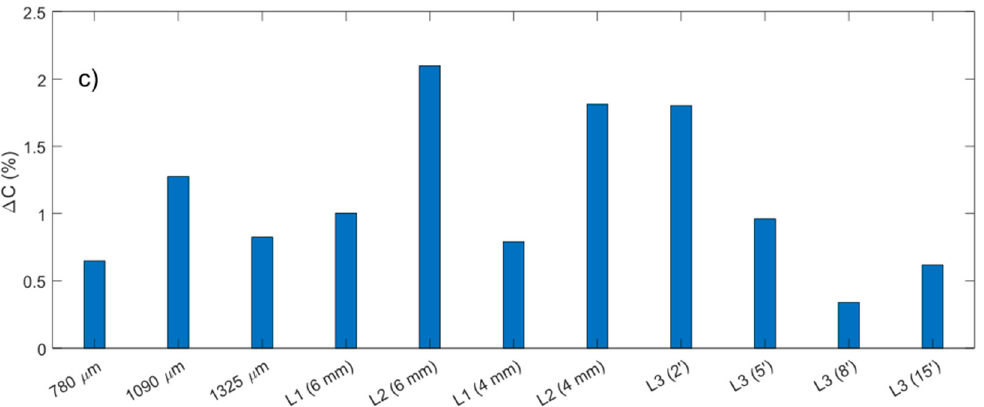
Figure 13. Absolute difference between the ( a ) toe length (TL), ( b ) width of mixing zone (WMZ) and ( c ) average difference of saltwater concentrations ( Δ C) derived by the two methods for the eleven investigated test images.